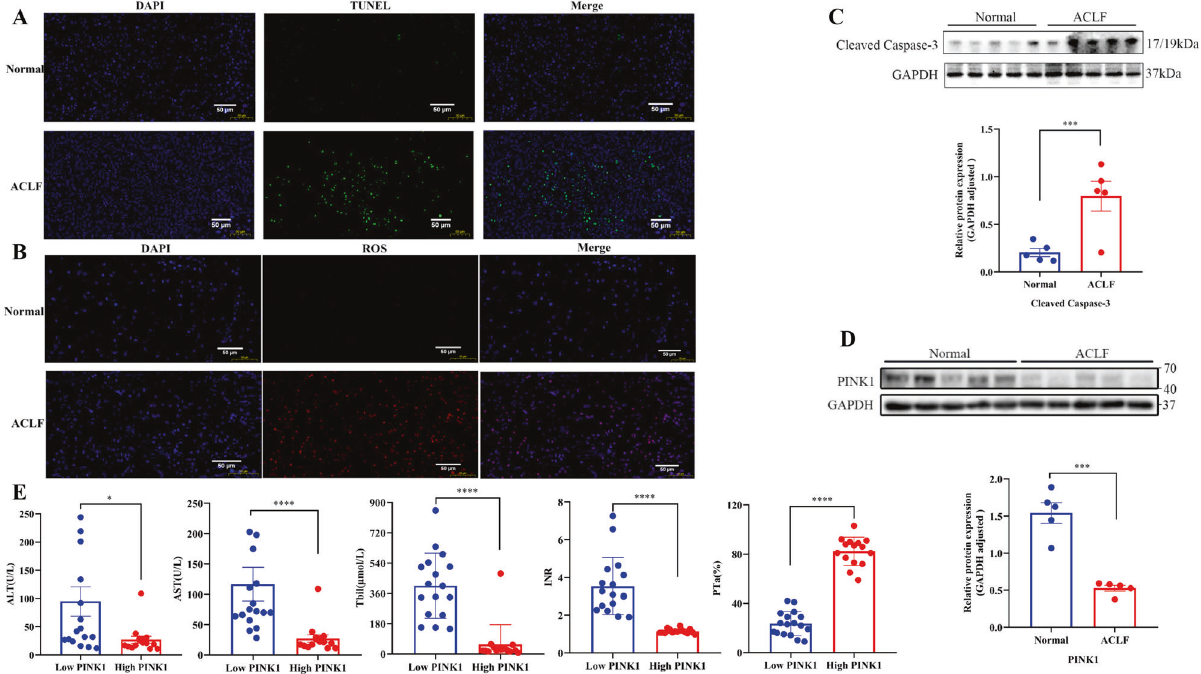
Fig. 1 Apoptosis and ROS are induced in the liver tissue of ACLF patients. A TUNEL staining of liver tissue samples (green: TUNEL-positive cells; blue: DAPI; scale bar, 50 µm). B DHE staining of liver tissue samples (red: ROS-positive cells; blue: DAPI; scale bar, 50 µm). C The protein levels of cleaved caspase-3 in human liver tissue samples were detected by western blotting and analyzed with the Image J software. D Protein levels of PINK1 in human liver tissue samples were detected by western blotting and quantitated with the Image J software. E ALT (U/L), AST (U/L), Tbil ( μ mol/L), INR, and PTa (%) at different levels of PINK1. * P < 0.05; ** P < 0.01; *** P < 0.001; **** P < 0.0001; ns not signi fi